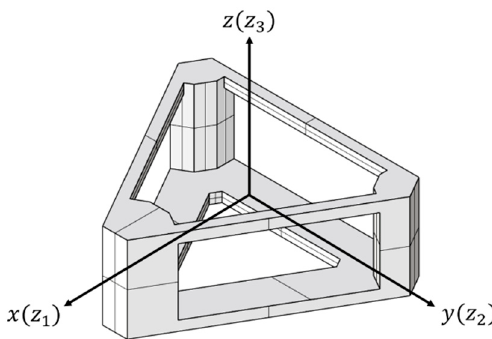
Figure A1. Coordinate system for viscous-flow formulation.